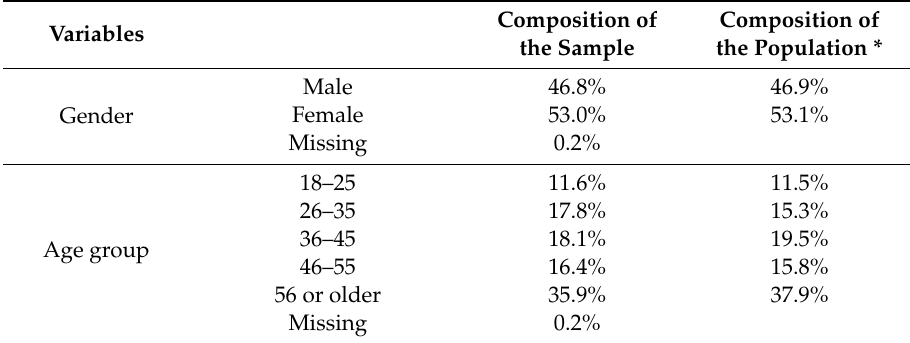
Table 1. Demographic and income properties of respondents ( n =